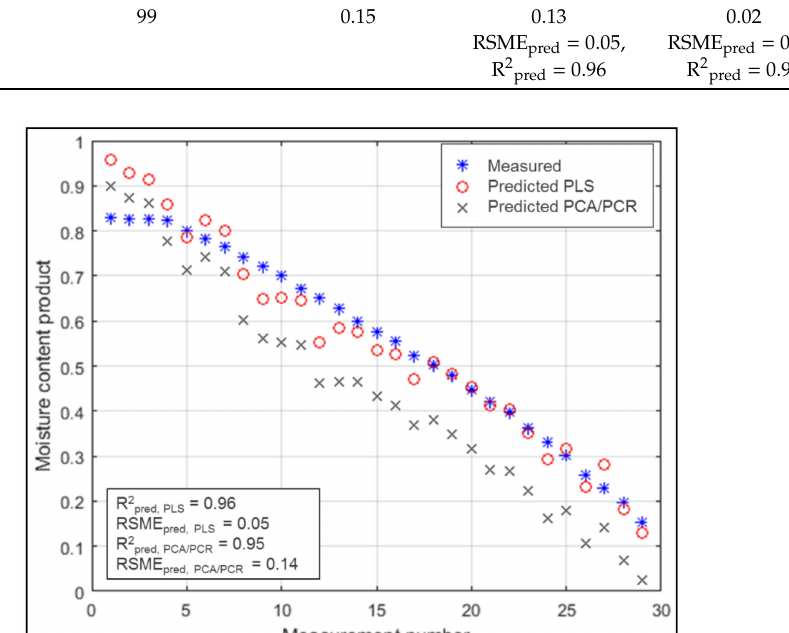
Figure 5. Moisture content x wb predicted and measured (PLS and PCA /